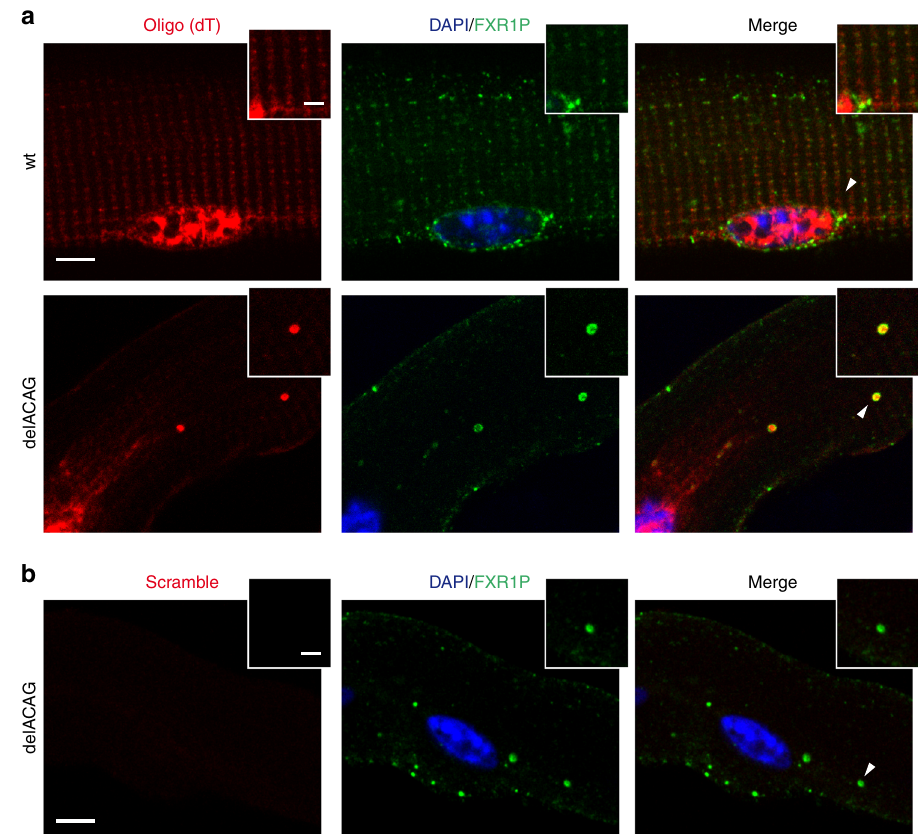
Fig. 8 DelACAG granules incorporate mRNA. a , b Confocal images (single Z-slice) of RNA-FISH on EDL isolated myo fi bers (wt and delACAG) using Cy3- oligo(dT) ( a ) or a Cy3-scramble probe ( b ) in combination with anti-FXR1P immunostaining proving positive oligo (dT) signal in delACAG granules ( n = 7). Scale bar 5 µ m. Higher magni fi cations correspond to the areas designated by arrowheads. Scale bar 2 µ m. Nuclei are stained with